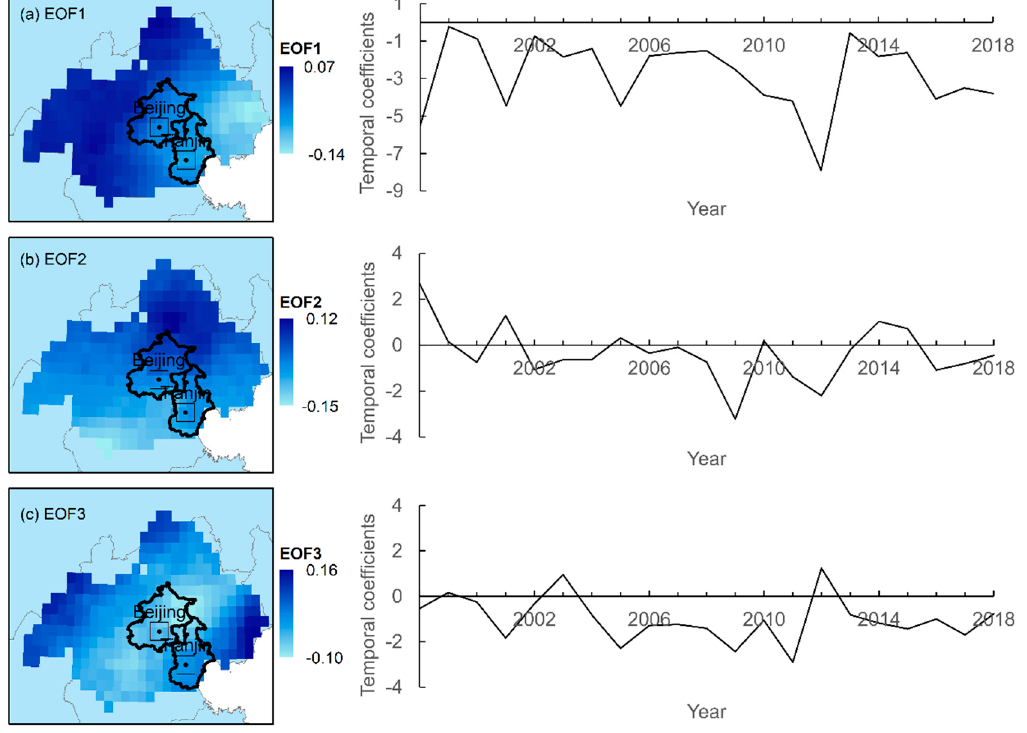
Figure 2. The first three spatial pattern and their corresponding temporal coefficients of the summer rainfall in study area by an empirical orthogonal function (EOF) analysis. ( a )( b )( c ) represent respectively the first leading spatial pattern, the second leading spatial pattern and the third leading spatial pattern.